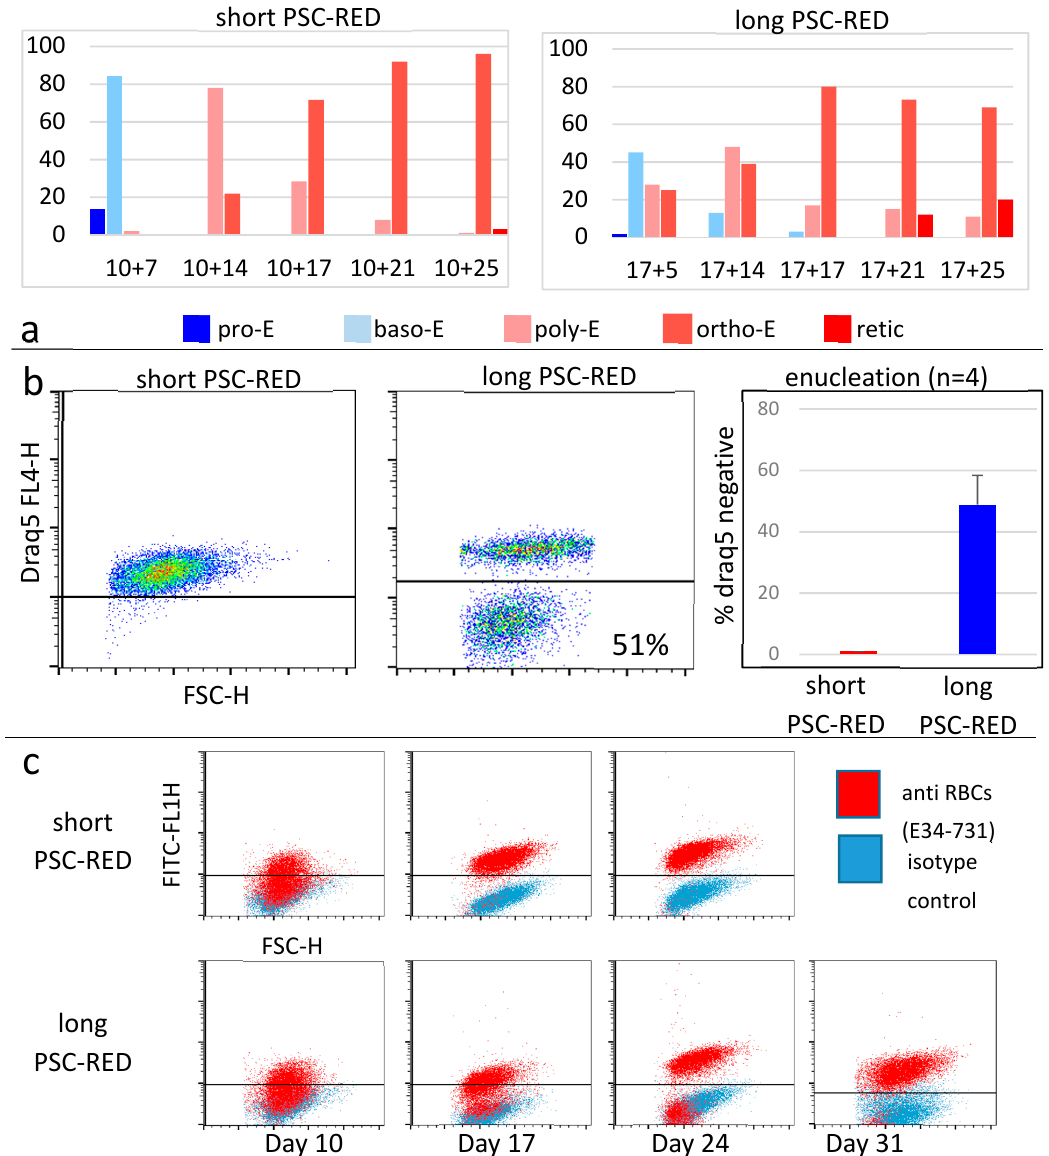
Figure 5. Differentiation analysis: ( a ) Cells were spun on microscope slides, stained using the rapid Romanowsky methods and classified as proE (pro-erythroblasts); basoE (basophilic erythroblasts); polyE (polychromatophilic erythroblasts); orthoE (orthochromatophilic erythroblasts) or retic. (reticulocytes (enucleated cRBCs)). Graphs illustrate the average (± SD) number of erythroid precursors during differentiation using either the short (left) or long (right) PSC-RED protocols ( n = 2); ( b ) FACS plots representative of the enucleation rates as determined by DNA content measurement using Draq5. The rate of enucleation is much higher using the long protocol (Student’s t -test p -value between the rate of enucleation short and long protocol in s: <0.00001) ( c ) FACS plots illustrating the proportion of erythroid cells during the culture using anti-baboon RBCs antibody E34- 731.